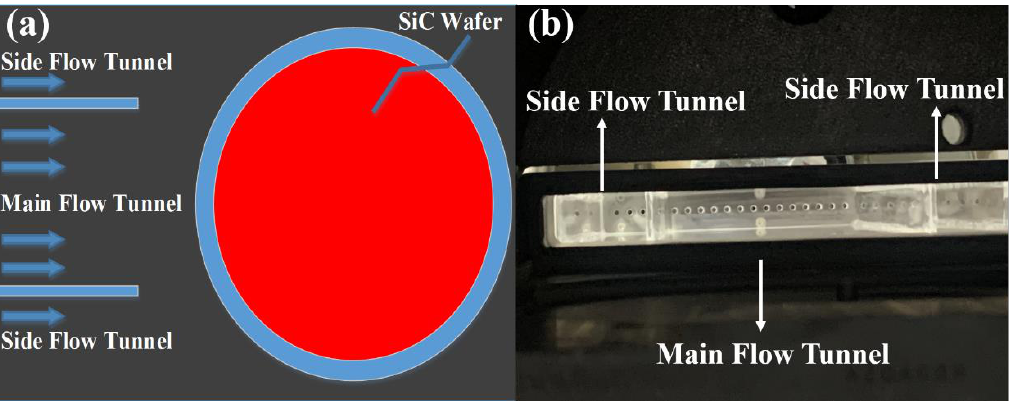
Figure 1. Flow tunnel image of CVD reactor chamber: ( a ) Schematic image, ( b ) Real image.